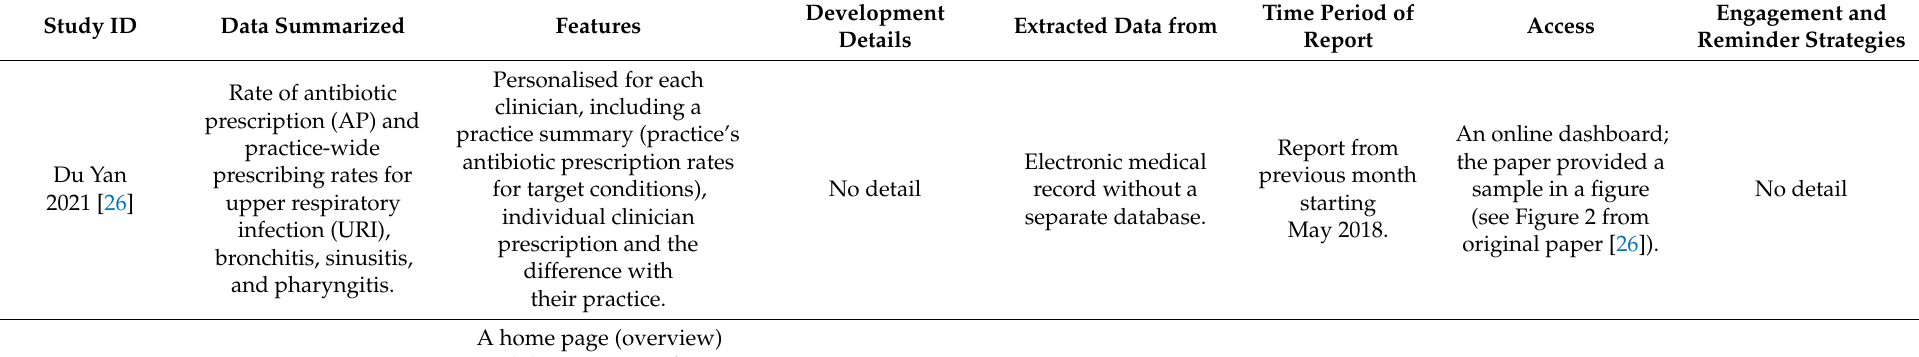
Table 1. Description of dashboard or visualisation tools included of interventions groups of studies